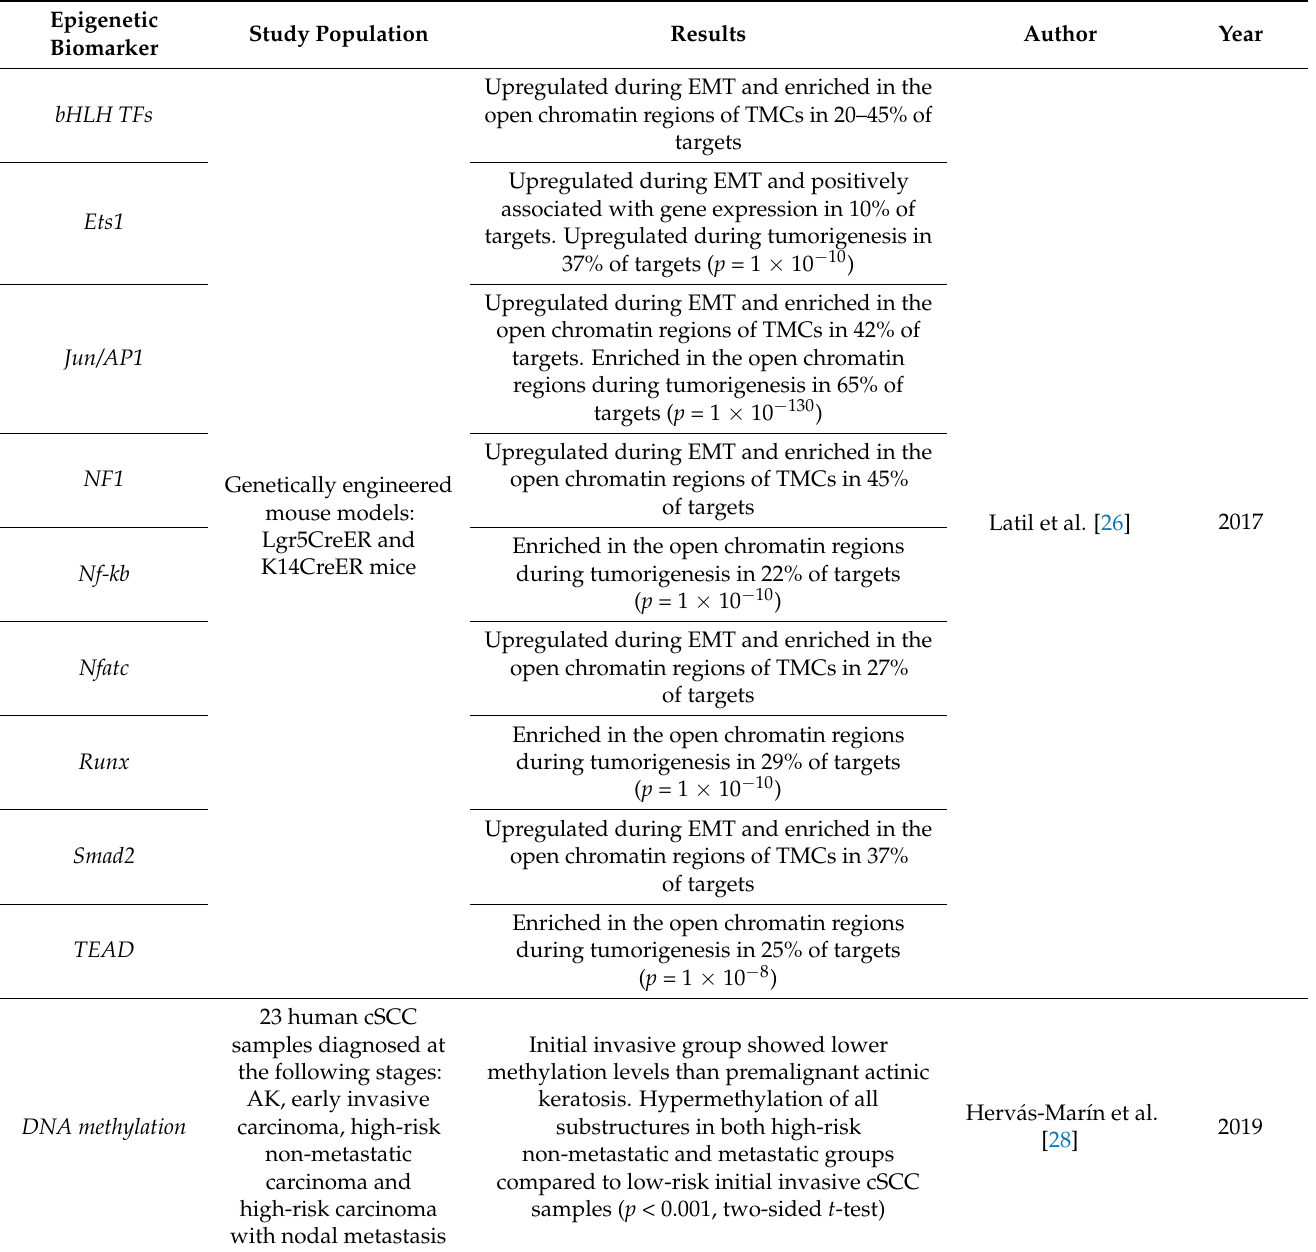
Table 5. Epigenetic alterations in